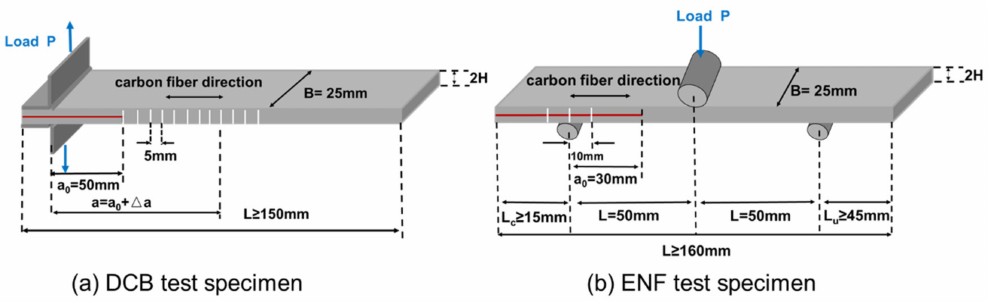
Figure 2. The geometry schematic of DCB ( a ) and ENF ( b ) test